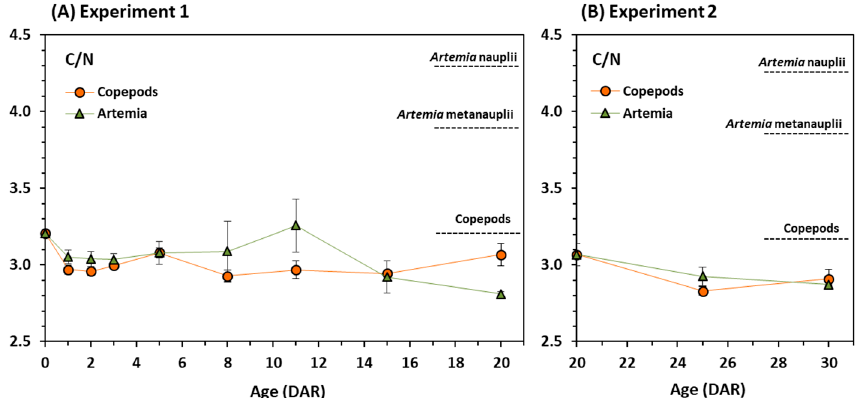
Figure 4. C:N ratios in juvenile seahorses Hippocampus guttulatus fed on copepods or Artemia over each experimental period. ( A )—Experiment 1: Juveniles fed on Artemia (nauplii and metanauplii) or copepods until 20 DAR; ( B )—Experiment 2: Juveniles fed on copepods in Experiment 1 until 20 DAR and subsequently fed on Artemia (nauplii and metanauplii) or copepods until 30 DAR. Horizontal dotted lines represent C/N values in prey (copepods and Artemia nauplii and metanauplii). Means and standard deviations are represented.